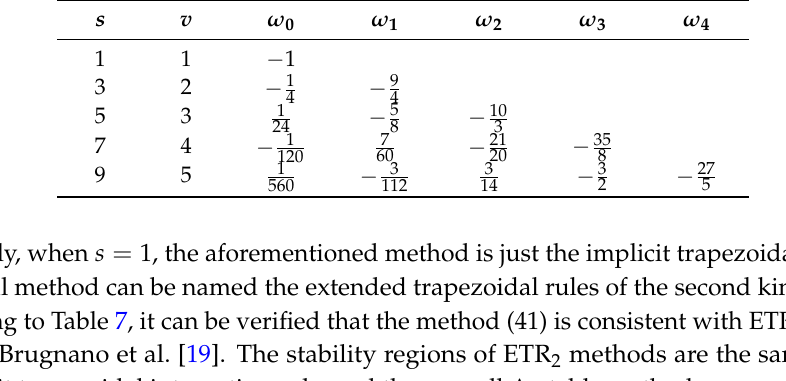
Table 7. Coefficients of extended trapezoidal rules of the second kind (ETR 2 ) using uniform grids.